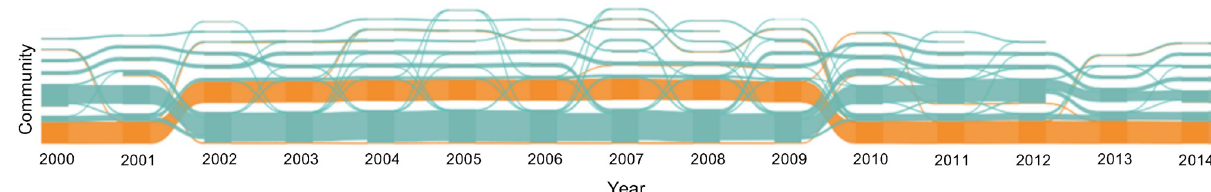
Fig 3. Sankey diagram of communities colored by actual regions where nodes are situated. Communities in each year are ordered by their size, from the largest to the smallest, from the bottom to the top. Green and orange in Fig 3 do not mean regional communities but mean the regions in which the node is positioned. The crossings of the major communities in 2001–2002 and 2009–2010 mean changes in the order of their size. Their classification of them is in S1 Table. The two bottom communities are major regional communities, but there had been other small European communities over the years.